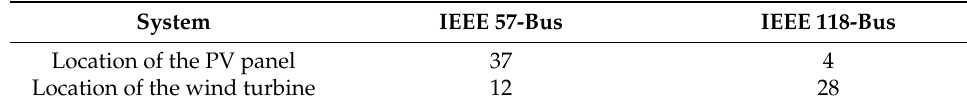
Table 7. Locations of the RESs in the 57- and the 118-bus systems.